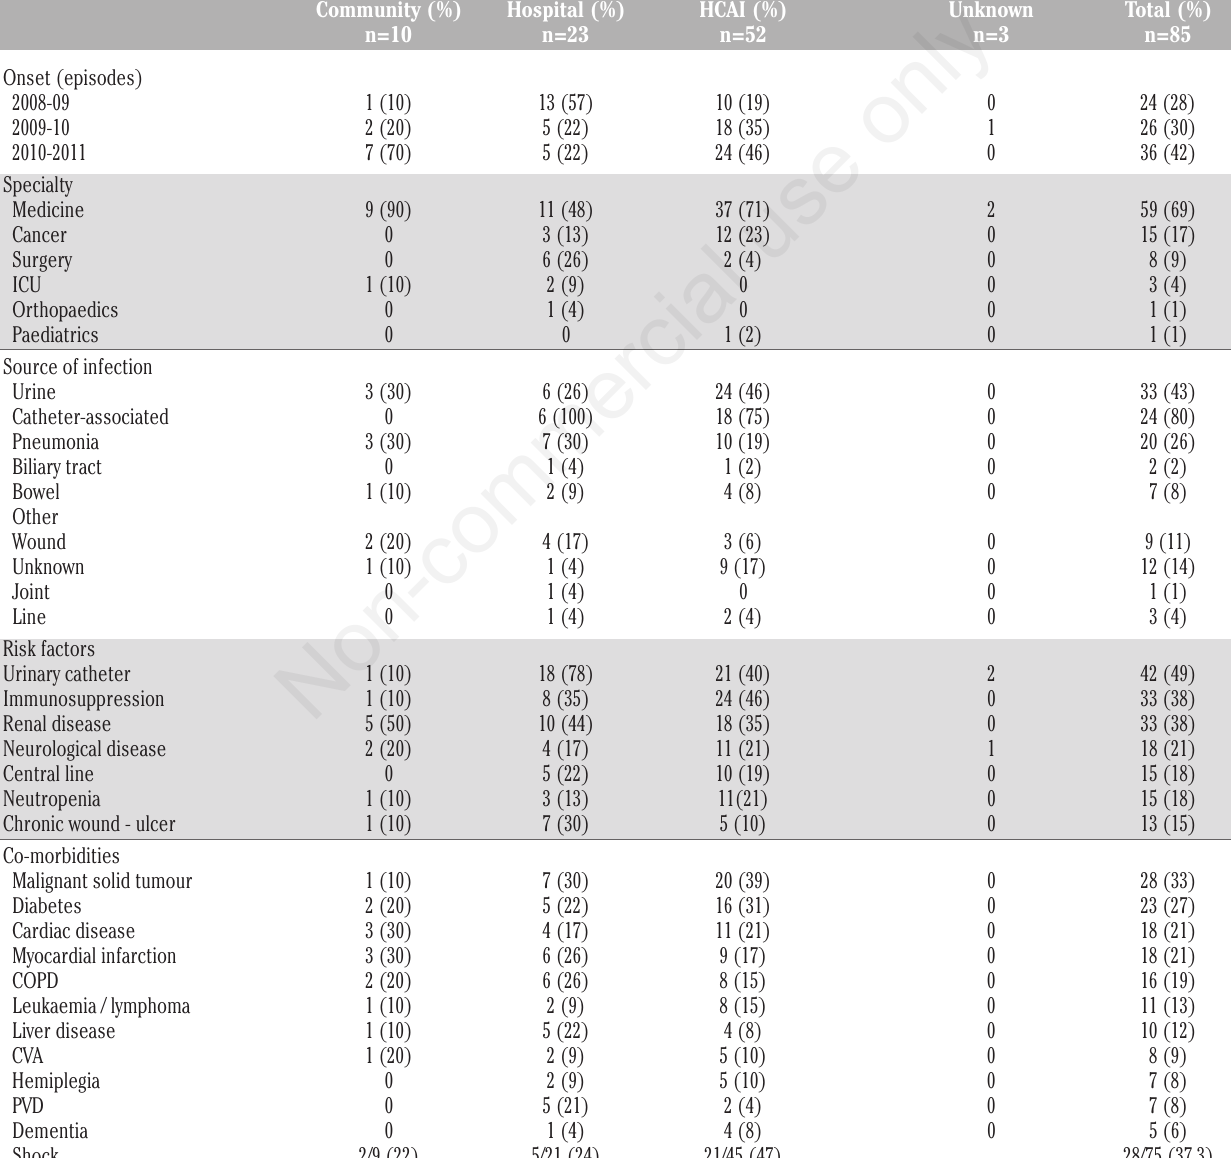
Table 1. Table of results by onset